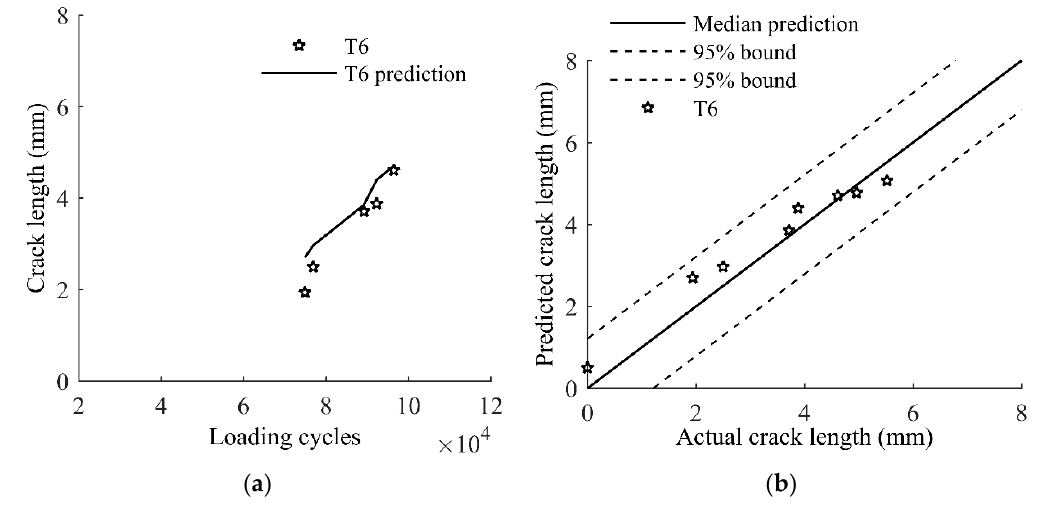
Figure 19. Model predictions and actual measurements of T6: ( a ) crack growth; and ( b ) crack lengths.